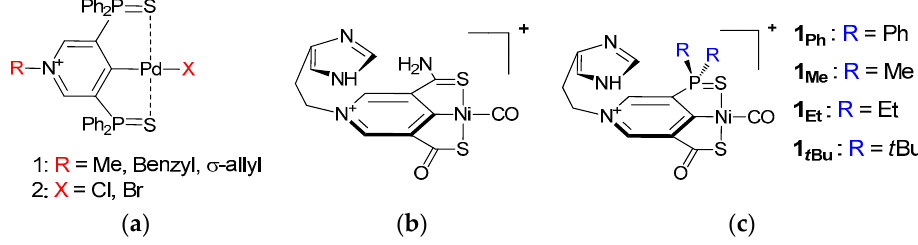
Figure 1. ( a ) Sulphur–carbon–sulphur (SCS) Pd pincer complexes synthesized by Meguro et al.; ( b ) SCS Ni pincer complex designed by Qiu and Yang; ( c ) unsymmetrical SCS pincer complexes proposed in this work .